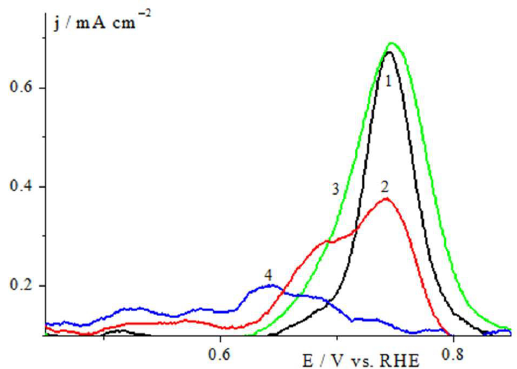
Figure 4. CO ad stripping voltammograms of the Pt/C (1), PtFe/C (2), PtMo/C (3), and PtMoSn/C (4), measured at a scan rate of 0.002 V s − 1 in 0.5 M H 2 SO 4 at room temperature. Metal loading is 2 μ g per electrode (~30 μ g cm − 2 ).